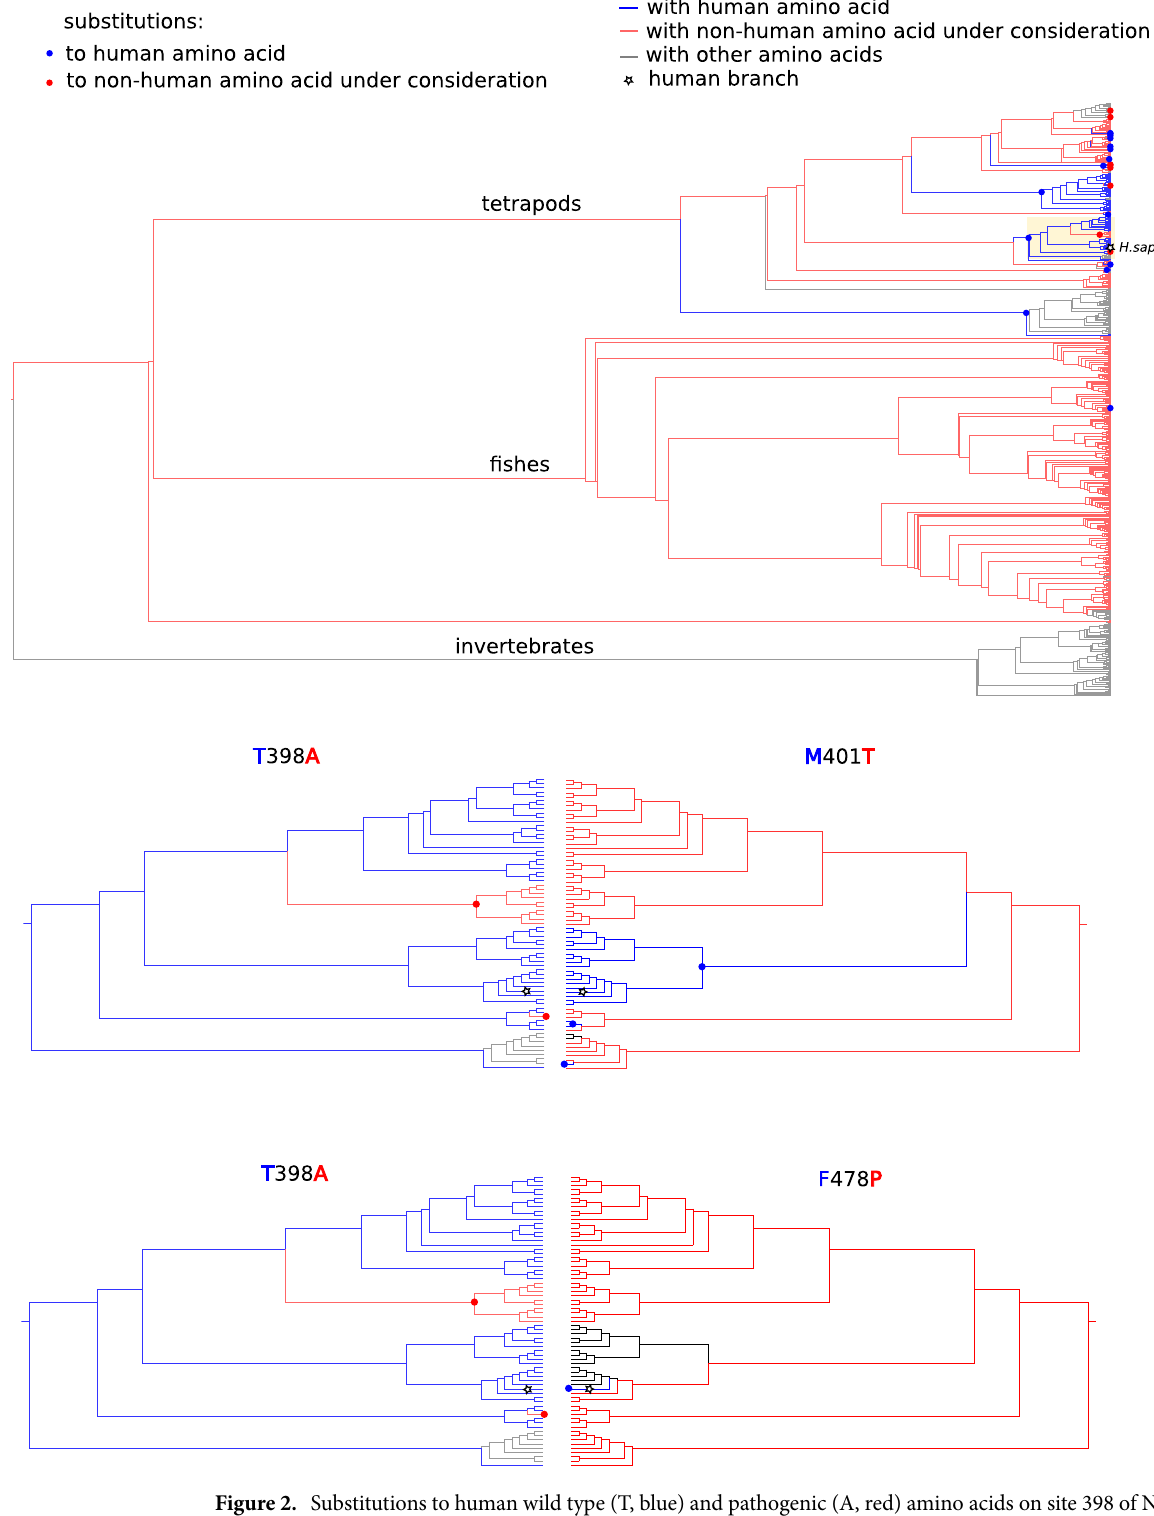
Figure 2. Substitutions to human wild type (T, blue) and pathogenic (A, red) amino acids on site 398 of ND5 on the cladogram. The cladogram is colored according to occupying amino acid: coral, A; blue, T; black, other amino acids. Primate clade has yellow background. Upper cladogram show the whole phylogenetic range considered, and other cladograms show primate clade. White star, Homo sapiens